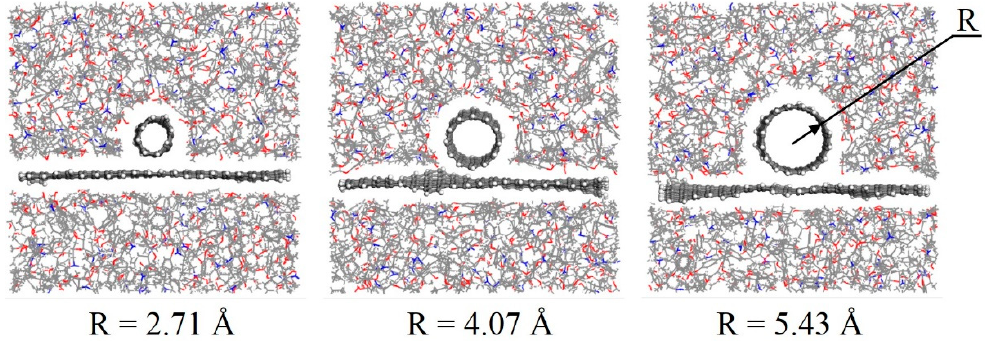
Figure 3. Equilibrium structures of composite models with different CNT radii.